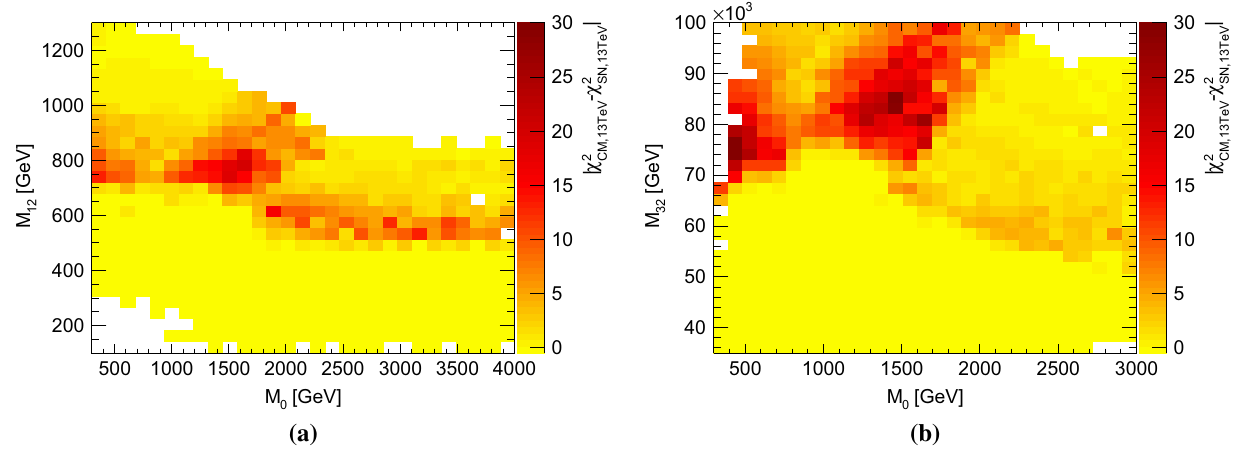
Fig. 16 Performance of the neural network trained on the reparametrized pMSSM-11 points on the cMSSM ( a ) and AMSB ( b ). In each bin the mean difference was calculated for all validation